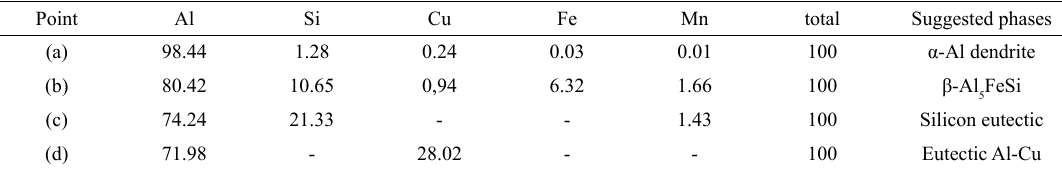
Table 3. EDS analysis of figure 3.b and the suggested phase (atomic %).